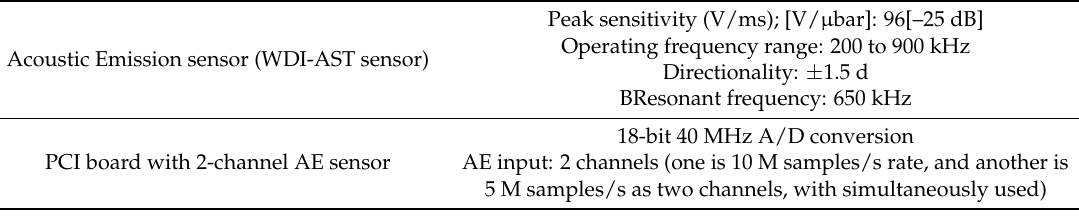
Table 2. Experimental setup details. PCI: peripheral component interconnect; WDI-AST: wideband differential; AE sensor.